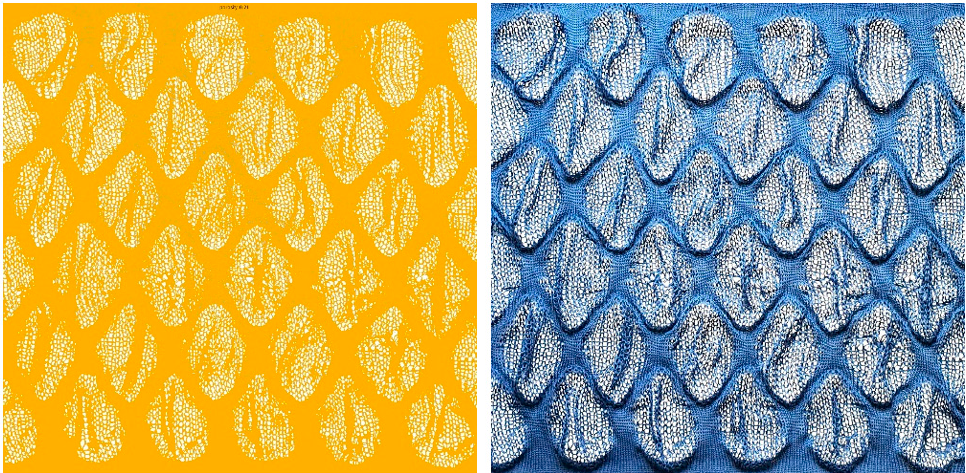
Figure 6. Porosity calculated by using a script in Processing (based on pixel darkness). The calculated porosity is illustrated through coloring pixels that count as solid, here represented in yellow.